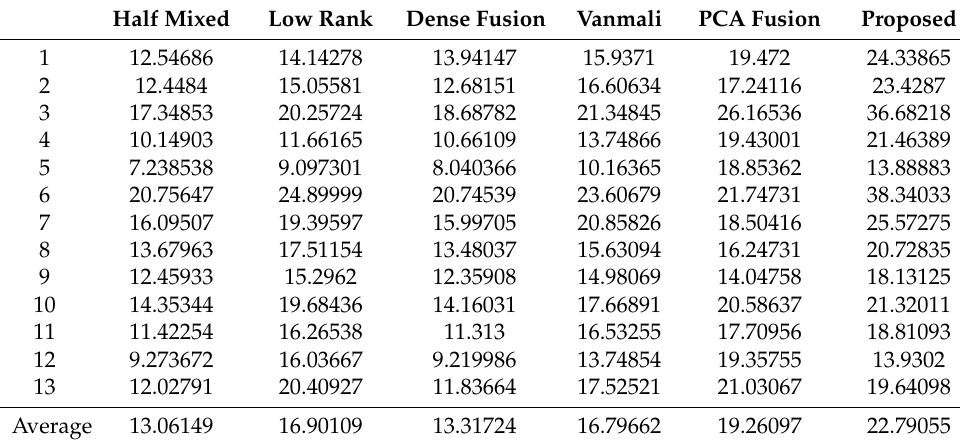
Table 3. Comparison of the spatial frequency metrics.